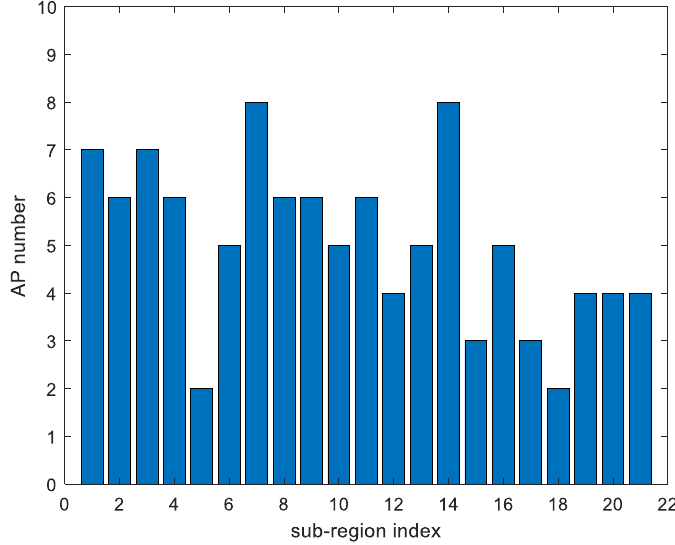
Figure 10. Statistics of AP optimization in sub-regions.